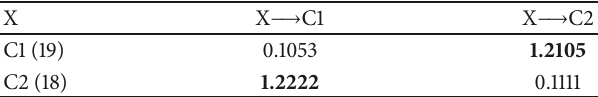
Table 3: The number of nodes in each cluster and the ratio of the numberofedgesbetweenclustersorinsidetheclustertothenumber of nodes in the cluster in Wikipedia who-votes-on-whom network (Fiedler